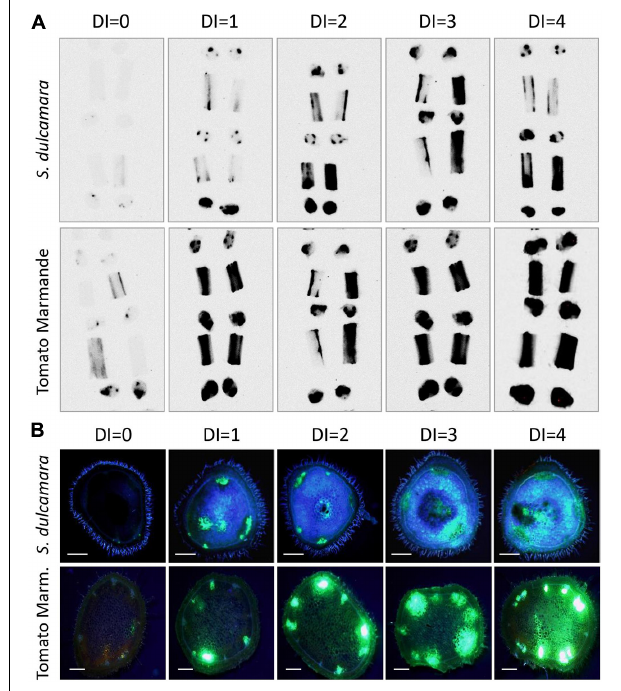
FIGURE 3 | R. solanacearum distribution in stems of inoculated S. dulcamara and tomato cv. Marmande plants. (A) Representative luminescence imaging photographs at different wilting stages (Disease index 0–4) of stem sections from S. dulcamara (top panel) and tomato (bottom panel) plants stem-inoculated with luminescent R. solanacearum . Luminescent bacteria are detected as dark areas in transversal and longitudinal sections of plant internodes 1–4 organised bottom to top. Inoculation points are indicated by an arrow. (B) Representative fluorescence microscopy images of stem sections from S. dulcamara (top panel) and tomato (bottom panel) plants stem-inoculated with an R. solanacearum strain constitutively expressing GFP. Inoculations were performed at the base of the first true leaf and transversal sections obtained in the first internode, 2 cm above the inoculation point. Scale bars indicate 0.5